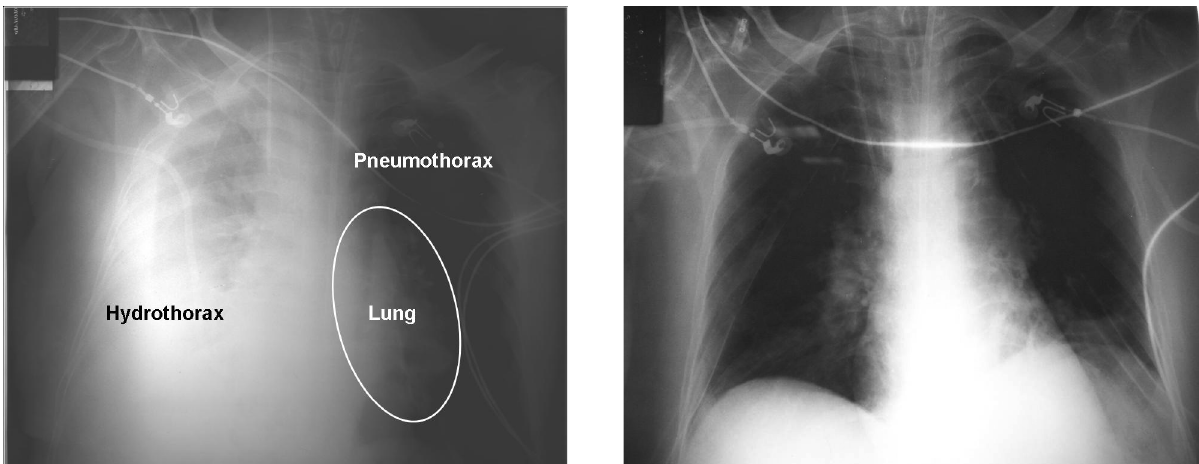
Figure 2 - Chest X-ray showing the left pneumothorax and right hydrothorax. Figure 3 - Chest X-ray after bilateral Table 1 - Summary of respiratory mechanics values, artery blood gas analyses, and hemodynamic variables.